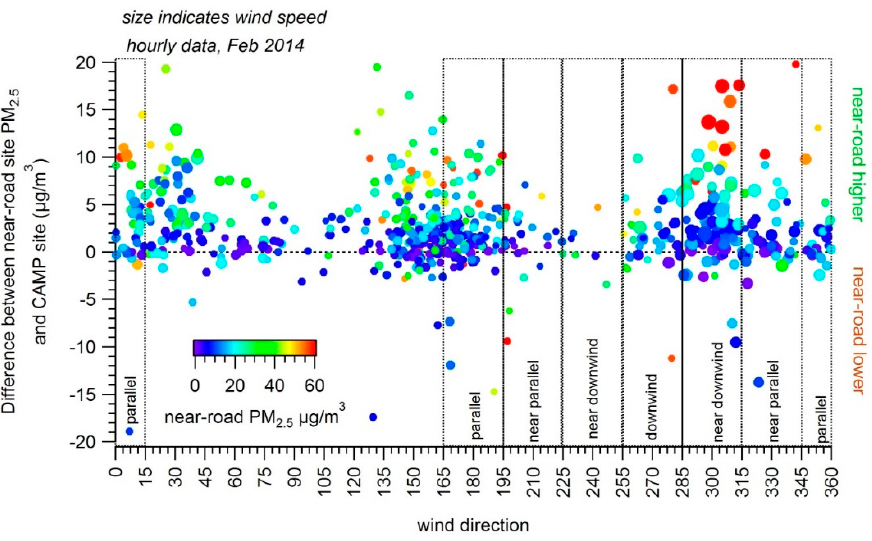
Figure 4. Denver PM 2.5 increment vs. winds. Wind direction is shown versus the difference between hourly PM 2.5 concentrations at the near-road site and the hourly PM 2.5 concentrations at the CAMP site for data collected during February 2014. Larger points indicate higher wind speed, and colors indicate near-road PM 2.5 concentration. Points above the horizontal dotted line indicate that hourly PM 2.5 concentrations at the near-road site were higher than concentrations at the CAMP site, whereas points below the line indicate that hourly PM 2.5 concentrations at the near-road site were lower than the CAMP site. Wind direction bins as defined in Figure 1 are also shown.